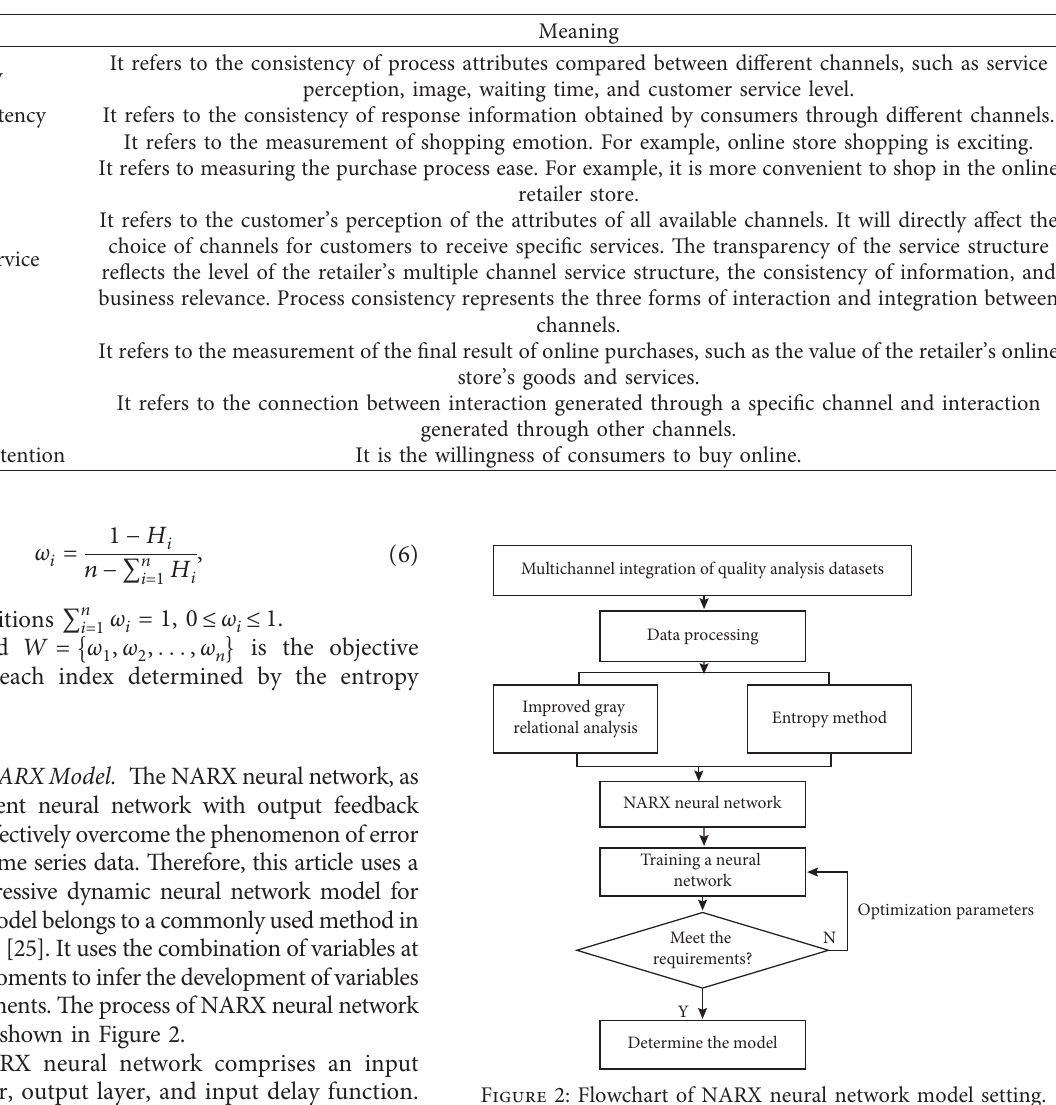
Table 1: Retailer’s MCIQ into 8 dimensions.